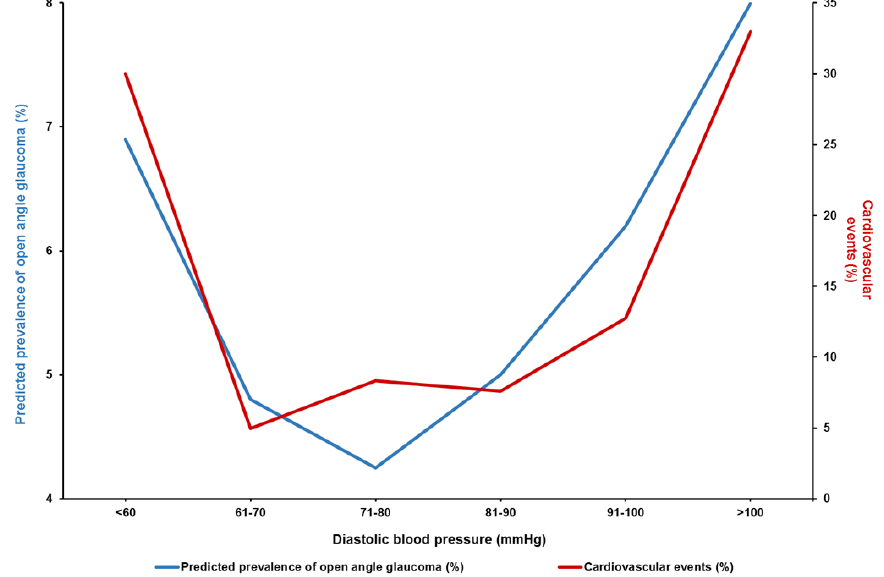
Figure 8. The relationship between diastolic BP (DBP) and the predicted prevalence of POAG in participants of the Los Angeles Latino Eye Study and cardiovascular events in the TNT study [50,76].